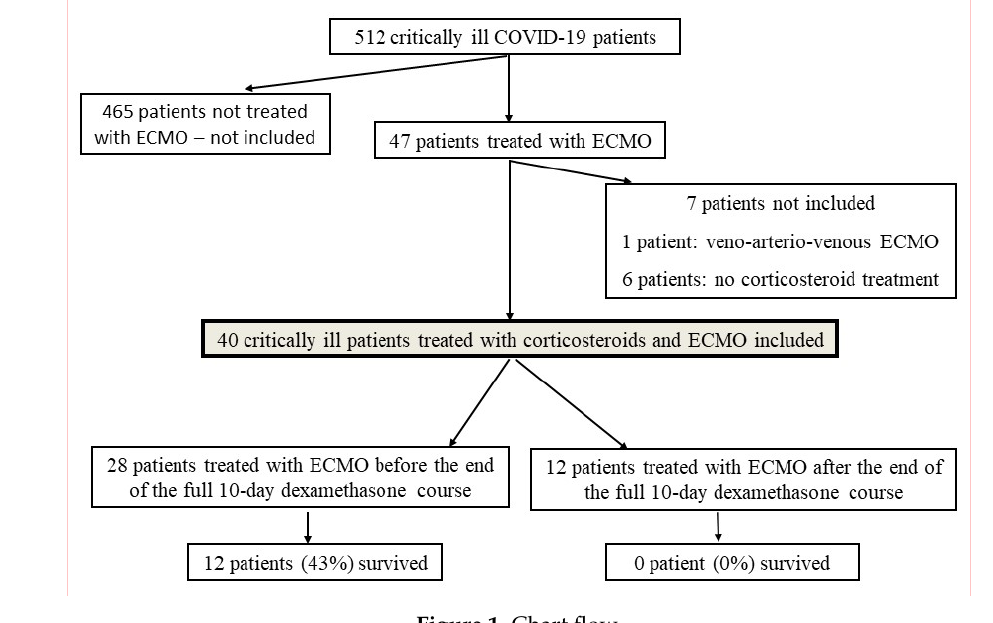
Figure 1. Chart flow. Table 1. Clinical characteristics on intensive care unit admission.